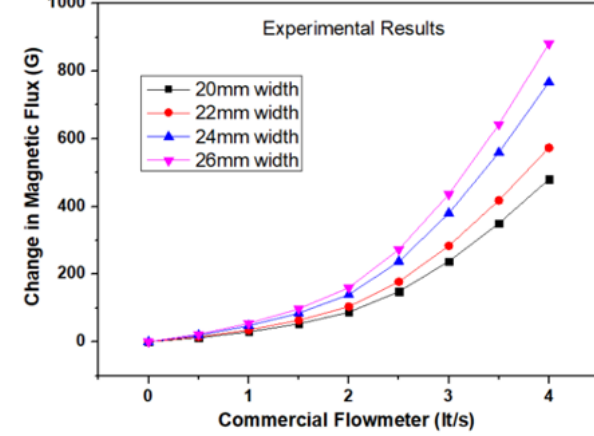
Fig. 6. Comparison of TFMS response against commercial flow meter response.